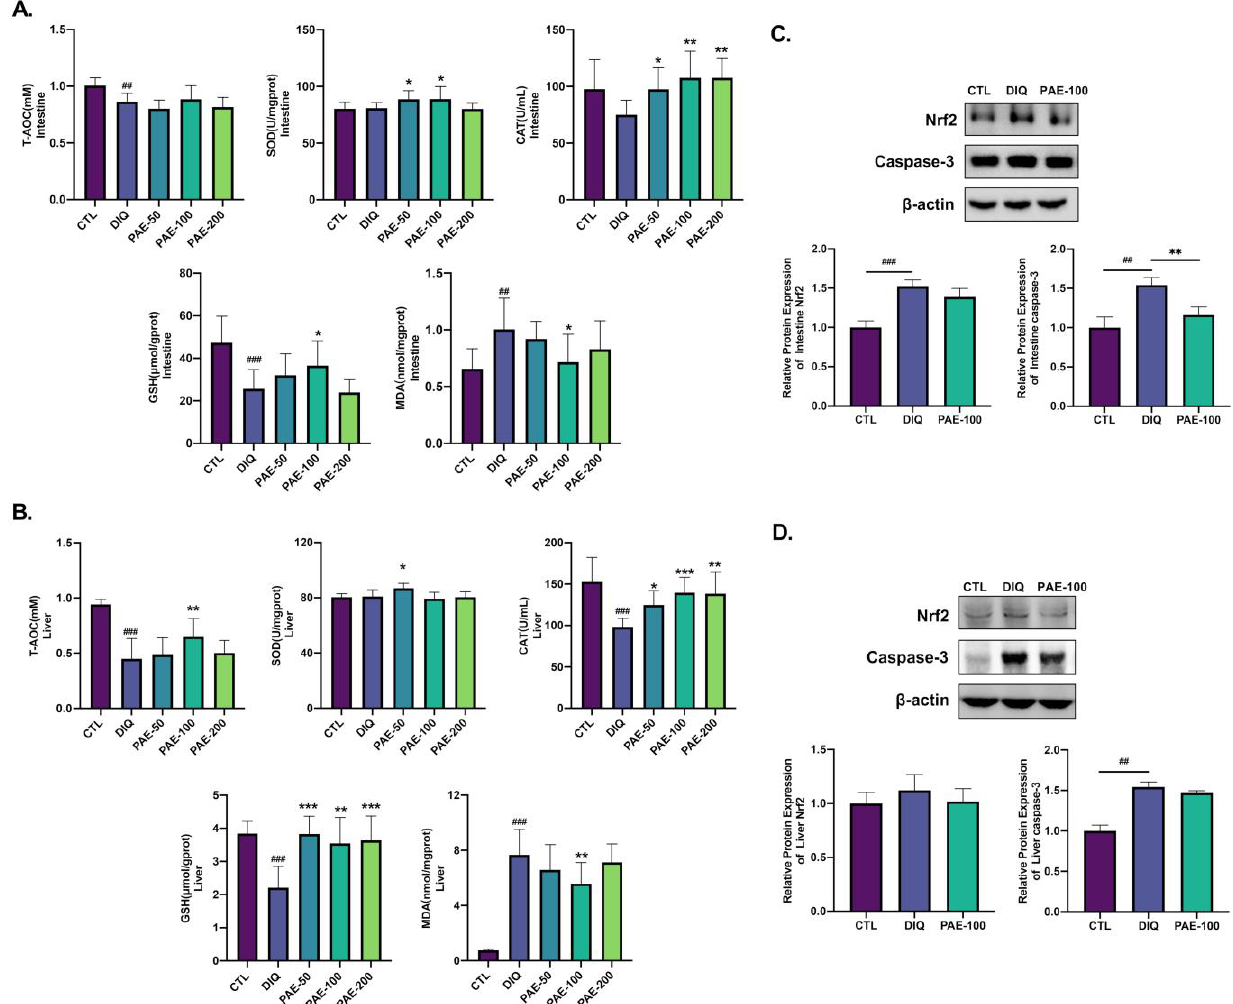
Figure 4. Effect of PAE on the antioxidant ability of the intestine and liver in diquat-treated mice: ( A ) Analysis of oxidative stress parameters (T-AOC, SOD, CAT, GSH, and MDA) in the intestine ( n = 8); ( B ) analysis of oxidative stress parameters (T-AOC, SOD, CAT, GSH, and MDA) in the liver ( n = 8); ( C ) analysis of the relative protein expression level (Nrf2 and caspase-3) in the intestine ( n = 3); ( D ) analysis of the relative protein expression level (Nrf2 and caspase-3) in liver ( n = 3). All data were represented as means ± SD. ## p < 0.01, and ### p < 0.001 as compared with control group; * p < 0.05, ** p < 0.01, and *** p < 0.001 as compared with the diquat group.